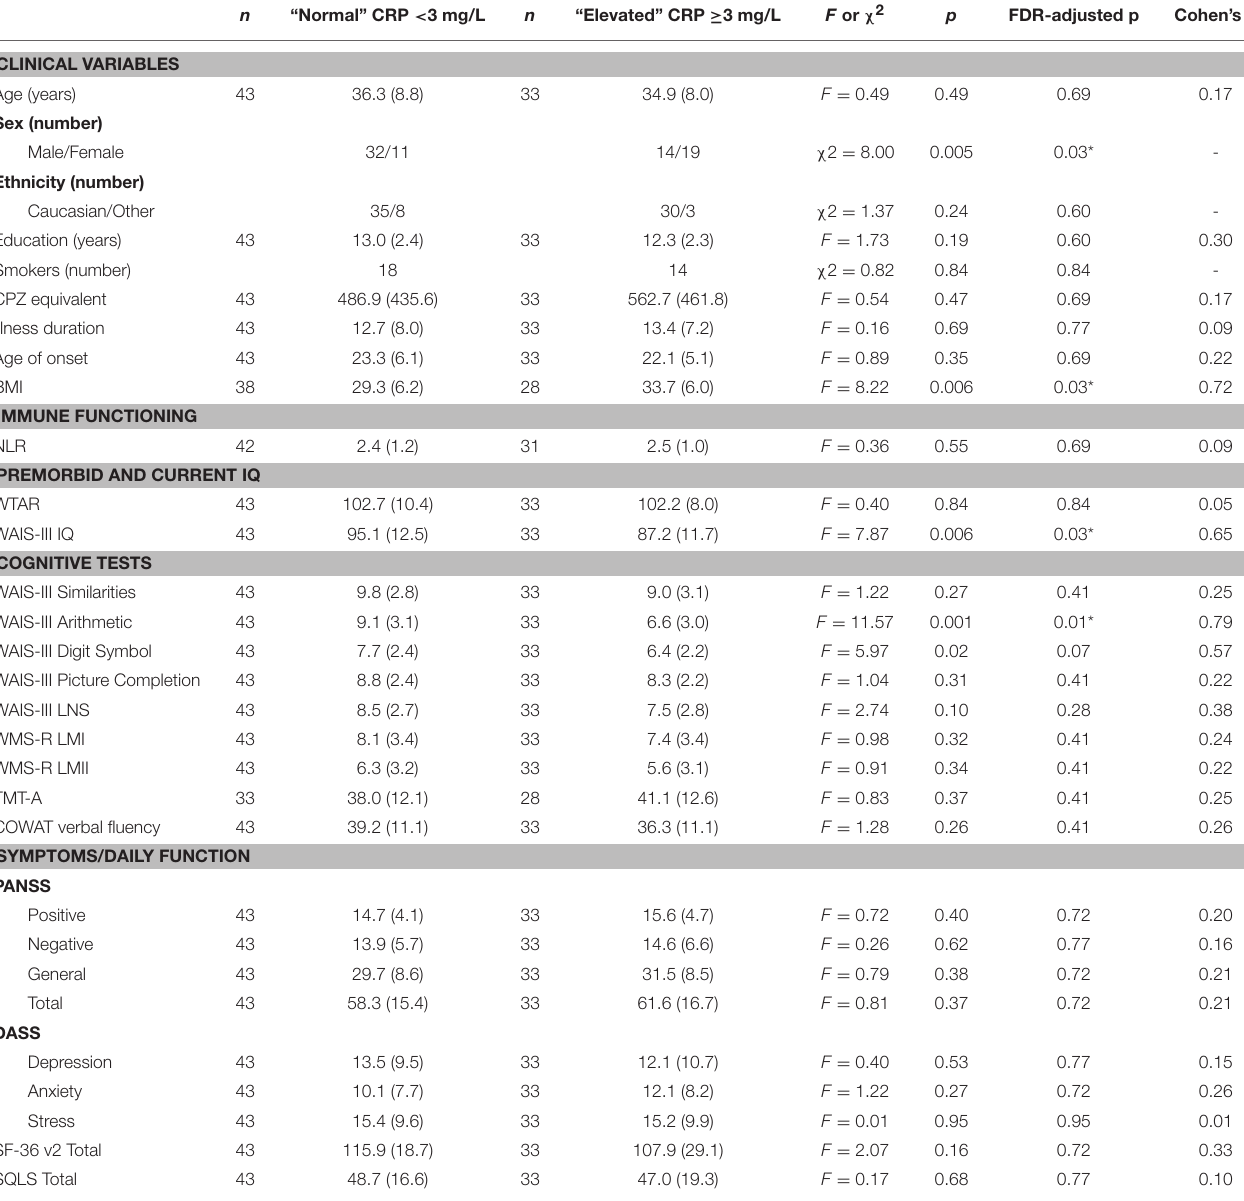
TABLE 9 | Comparison of demographic, clinical, cognitive, symptom severity, negative emotional states, daily function and quality of life measures between normal and elevated CRP groups in patients with schizophrenia. n “Normal” CRP < 3 mg/L n “Elevated” CRP ≥ 3 mg/L F or χ 2 p FDR-adjusted p Cohen’s